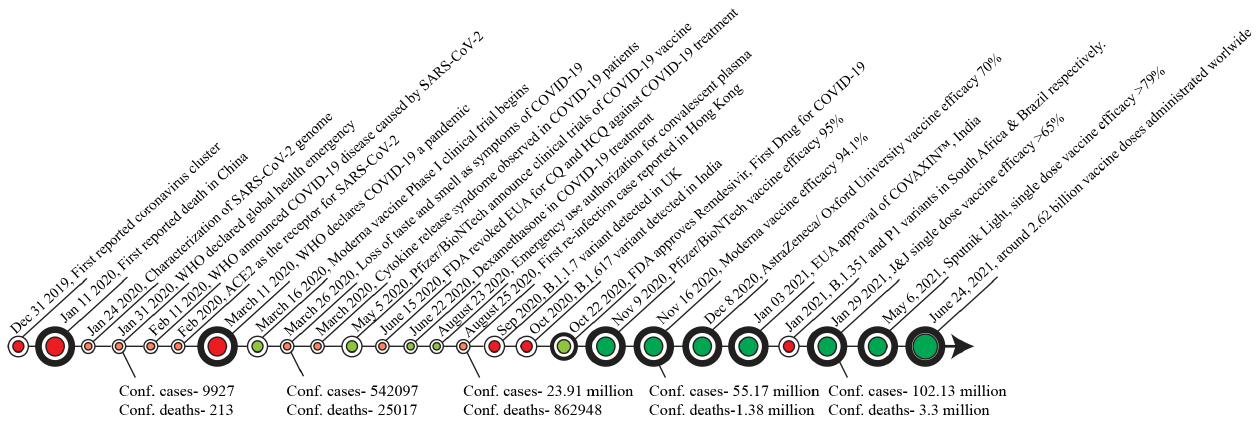
Figure 1. Timeline of major key events in the progression of the COVID-19 pandemic and vaccine development. Counts shown here are cumulative confirmed (Conf.) cases and deaths worldwide (https://ourworldindata.org/- Source- Johns Hopkins University CEES COVID-19 DATA, Accessed date: 28 th May 2021). CQ, Chloroquine; HCQ, Hydroxychloroquine; EUA, emergency use authorization.